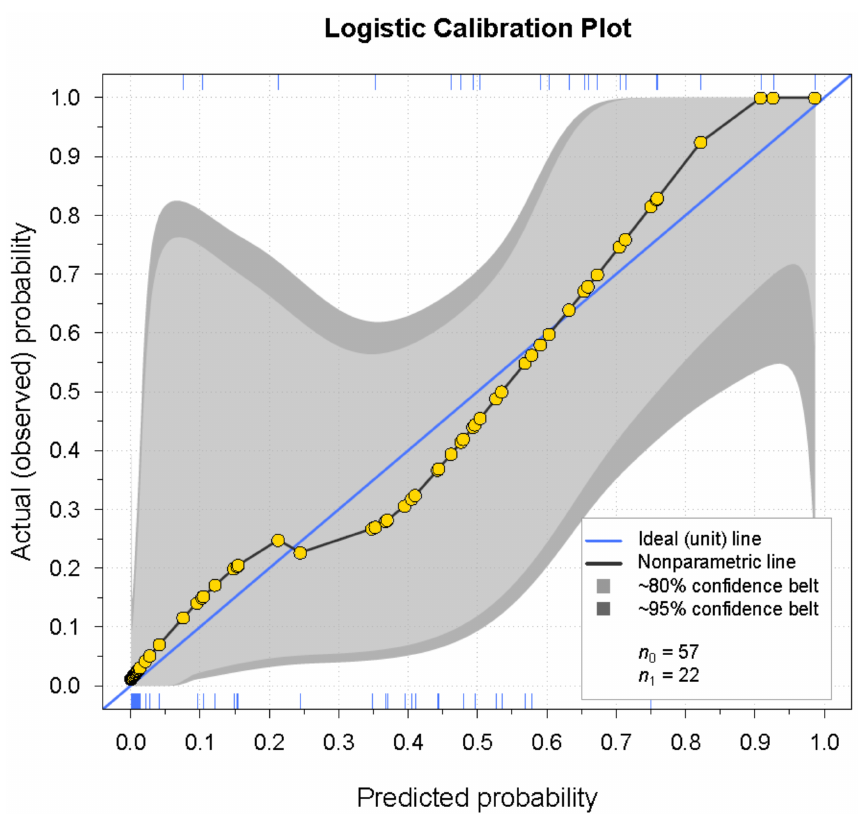
Figure 5. Calibration belt plot with 80% and 95% confidence intervals. The blue diagonal line represents the ideal calibration line, where predicted probability equals actual (observed) probability. The black line with the gold observation points represents the fitted logistic regression model. The model did not differ significantly from the ideal line, p = 0.70. The rugs at the bottom and top of the plot give an impression of the density of the predictions for controls and patients, respectively. The calibration belt was plotted according to the method described in